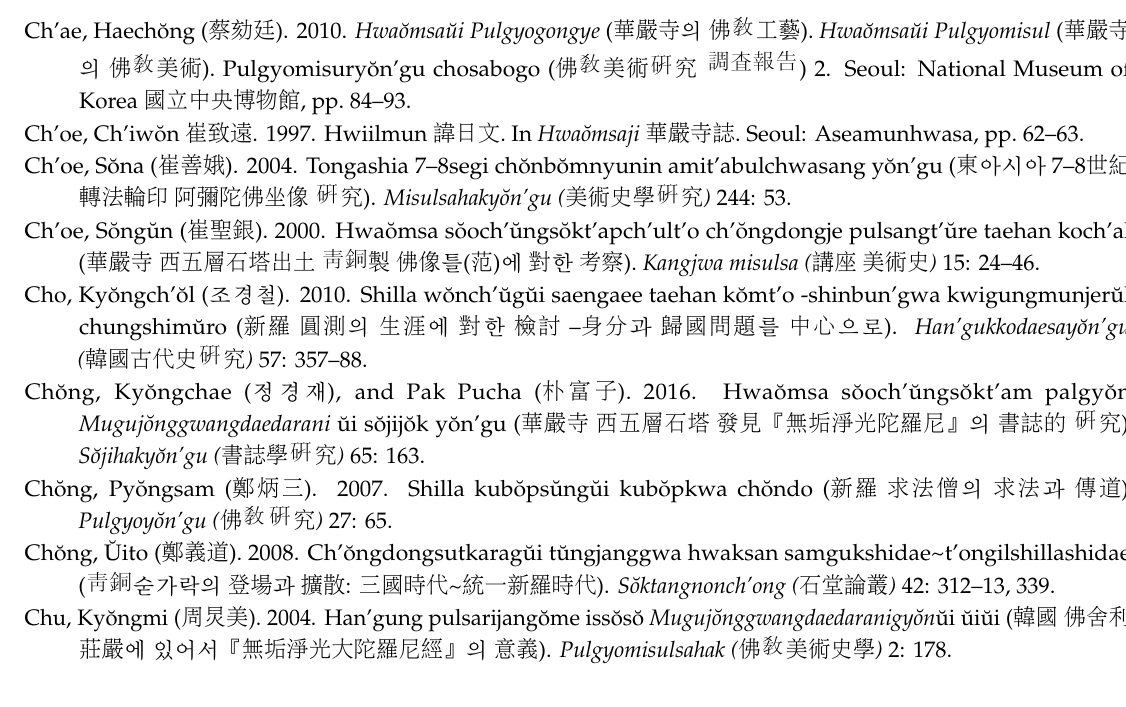
Figure 20. Clay Buddha, Pagan period, 12th–13th centuries, 9.6 × 7.1 cm, Myanmar [Source: (Fukuoka Art Museum 2008, cover picture)].